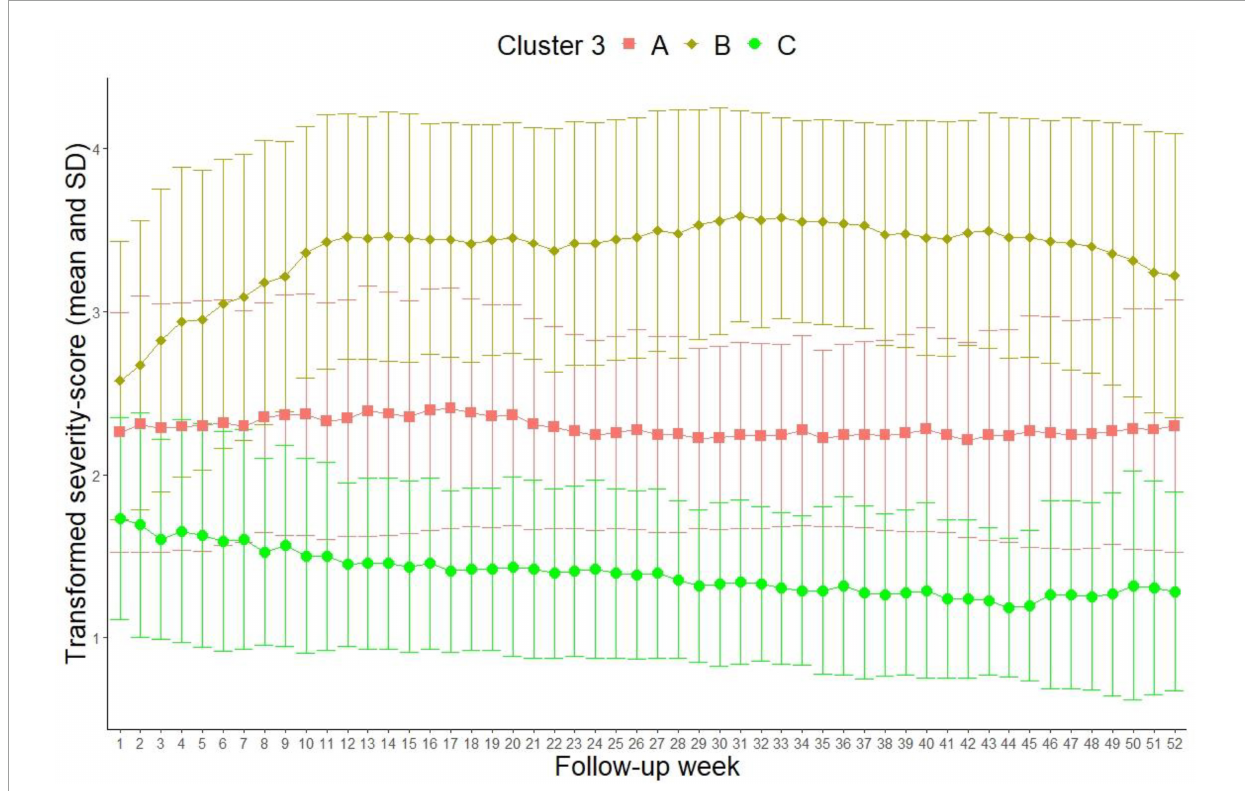
FIGURE3 3-cluster solution (Transformed severity score out of MDE 6-point scale: 1 = 1 in MDE 6-point scale = healthy, 2 = 2 and 3 in MDE 6-point scale = residual symptoms and partial remission, 3 = 4 in MDE 6-point scale = depressive symptomatology without meeting full diagnostic criteria, 4 = 5 and 6 in MDE 6-point scale = meeting diagnostic criteria for unipolar depression and showing possible psychotic symptoms or extreme